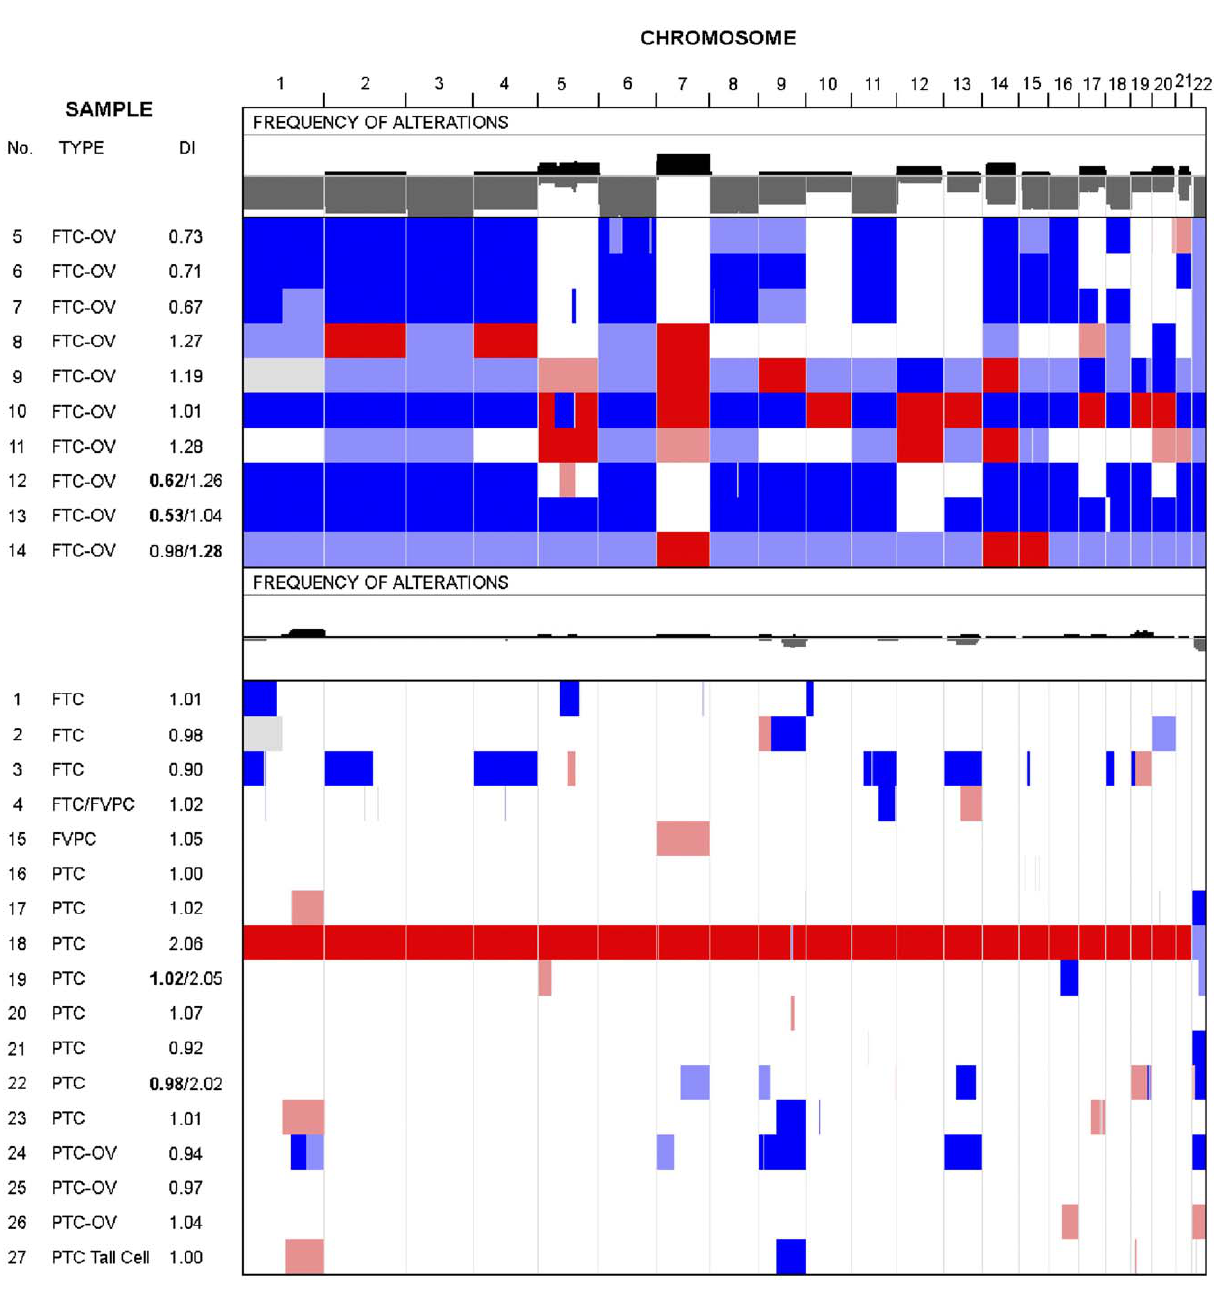
Figure 3. Summary of the genomic alterations found after LAIR analysis (see Materials and Methods) in 27 recurrent NMTCs. In this heatmap, rows represent tumours and columns represent chromosomes. The first column shows the tumour number, type and DNA index (DI). The tumours have been grouped according to their subtype, with ten FTC-OV tumours in the upper group and 17 NON FTC-OV in the lower group. The combined frequency of genomic alterations for each group is indicated in a separate row. Black indicates allelic states with . 2 copies and at least one B allele retained, e.g. [AABB] and [AAB]. Grey indicates allelic states of [A] and [AA]. The colours in the heatmap indicate: white, allelic state [AB]=normal heterozygous state. Dark red, allelic states [AABB], [AAABBB], etc.=amplified heterozygous states. Light red, allelic states [AAB], [AAABB], etc.=imbalanced gain. Dark blue, allelic state [A]=LOH or physical loss in the context of a diploid genome but monosomy in the context of a haploid genome. Light blue, allelic states [AA], [AAA], etc.=copy neutral LOH and amplified LOH, respectively. Notice the retention of